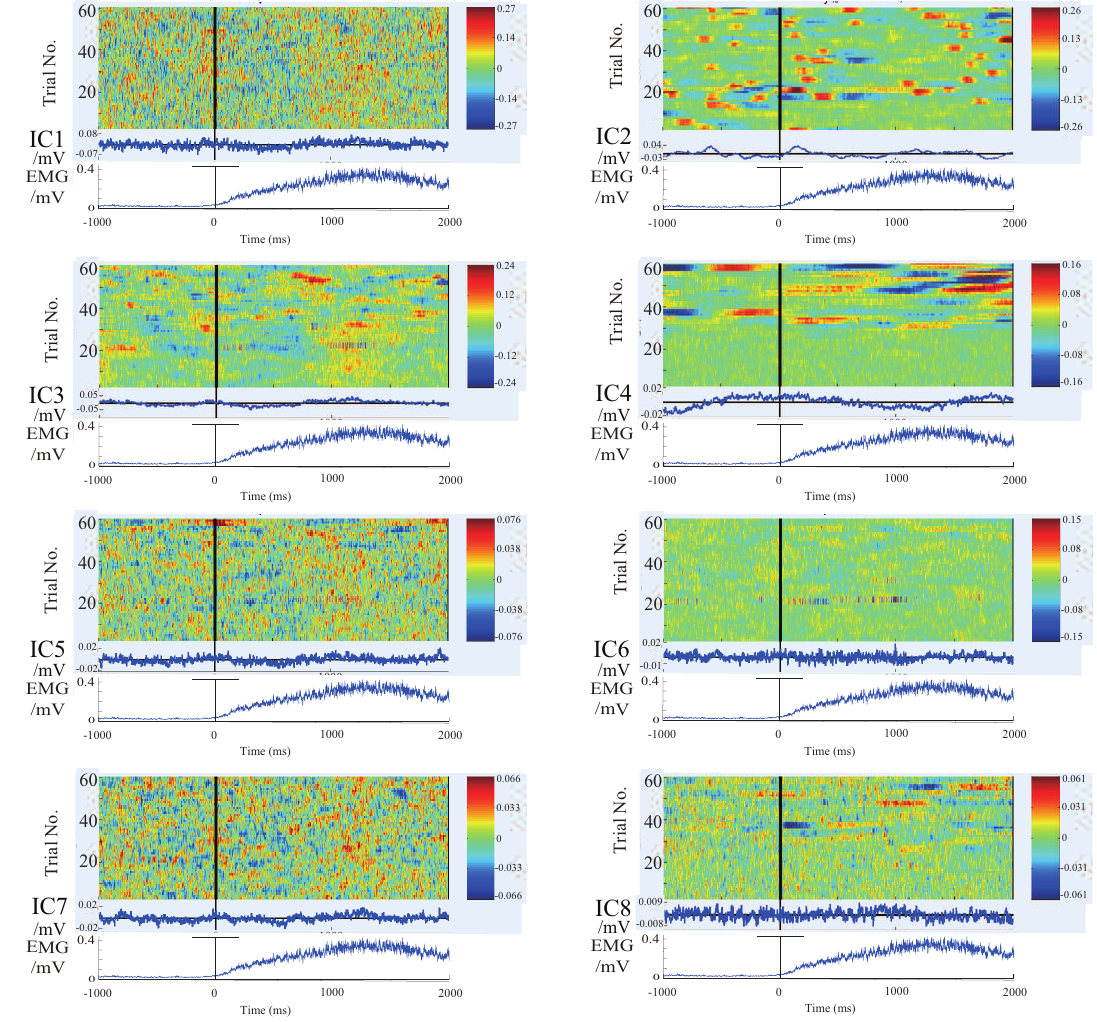
Figure 6. The waveform of each independent component in each experiment of subject C. 8 subpanels in the figure correspond to 8 independent components (IC1–IC8). The upper part of each subpanel shows the amplitude of the independent component restored to all trials at time series, which is plotted by color. The horizontal axis is time, and the black vertical line divides the 3-s data to 1 s before the motion and 2 s after the motion. The vertical axis is the number of trials. The IC part is an average value of EEG signals of all the waveforms produced by all the trials. The lower part is an average value of EMG signal of all the